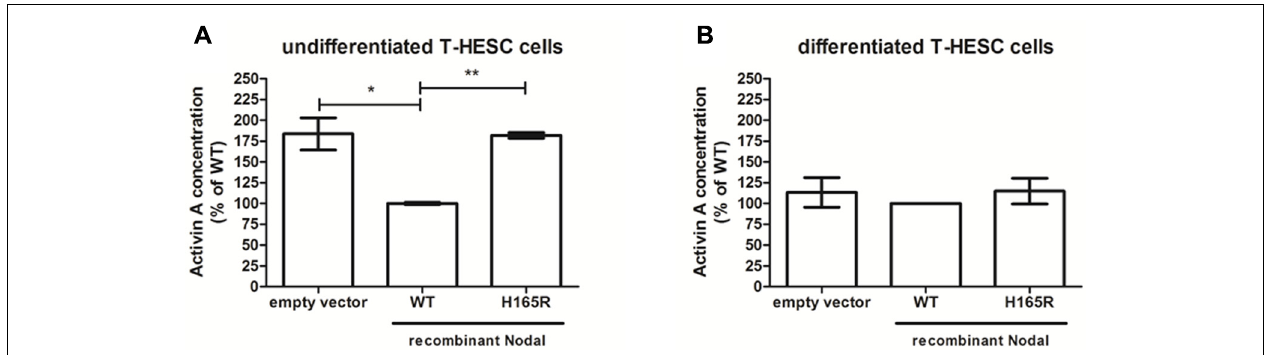
FIGURE 6 |Activin-A in conditioned media from undifferentiated and differentiatedT-HESC cells. Activin-A concentration levels in conditioned media from undifferentiated ( n = 4) (A) and differentiated ( n = 2) (B) T-HESC cells transfected with empty vector, wildtype (WT) or H165R Nodal constructs. * P < 0.05; ** P < 0.01.